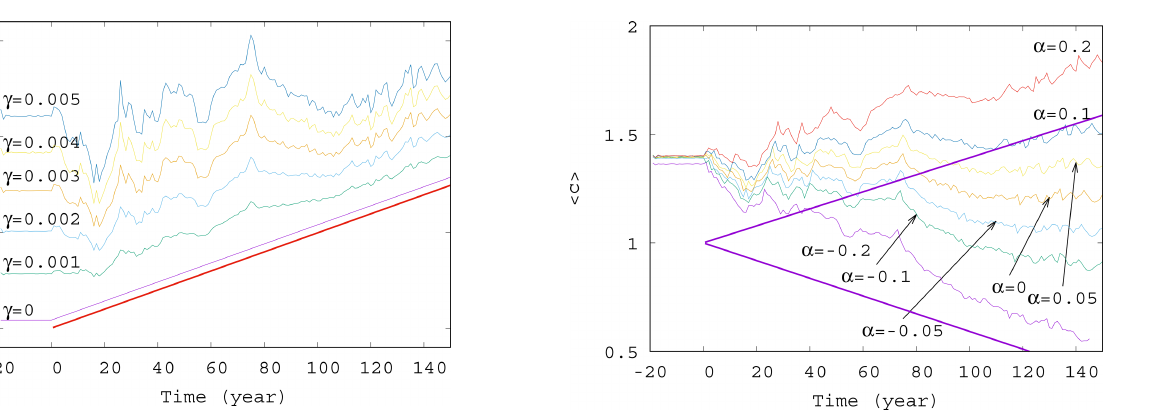
Figure 5. Average phytoplankton concentration < c > as a function of time for γ = 0 . 01 for various values of α ( − 0 . 2, − 0 . 1, − 0 . 05, 0.0, 0.05, 0.1, and 0.2). The thick purple lines show the expected phytoplankton concentration without mixing ( γ = 0) as predicted by Eq. (11) for α = − 0 . 2 (lower line) and α = 0 . 2 (upper